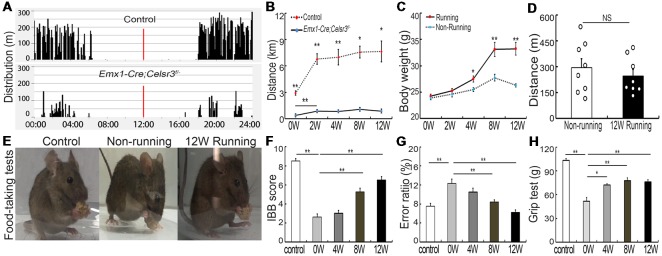
Wheel running improves motor performance in Emx1-Cre;Celsr3f/- mutants. (A) Nycthemeral activity chart in control and mutant mice shows that mutants run during the dark period like controls, albeit less extensively. (B) Distance covered during 24 h by running in the wheel is lower in mutants than controls. *P < 0.05; **P < 0.01; n = 8. (C) Body weight increases in runners vs. non-runners after 8 weeks (8W) of exercise. *P < 0.05; **P < 0.01; n = 8. (D) Distance covered by walking in the cage is comparable in non-runners and runners after 12 weeks (12W) of running. Each circle represents the data from one animal. P > 0.05; n = 8; NS, not significant. (E) Examples of food-taking test performances in control, non-runner and runner mutants. Most 12-week runner mutants (6/8) could easily lift food pellets from the floor, like control animals (8/8), whereas non-runner mutants (0/8) failed to do so. (F) Irvine, Beatties and Bresnahan (IBB) scores in runners display a significant increase after 8 weeks (8W) of exercise and peak at 12 weeks (12W) compared to non-runners. **P < 0.01; n = 8. (G) Gait coordination, estimated by grid tests, shows higher error rate in the mutant than in the control, with gradual improvement during exercise. **P < 0.01; n = 8. (H) Muscle strength assessed by grasping tests. Forelimb strength in mutants is lower than in control mice and gradually increases with training. *P < 0.05; **P < 0.01; n = 8.